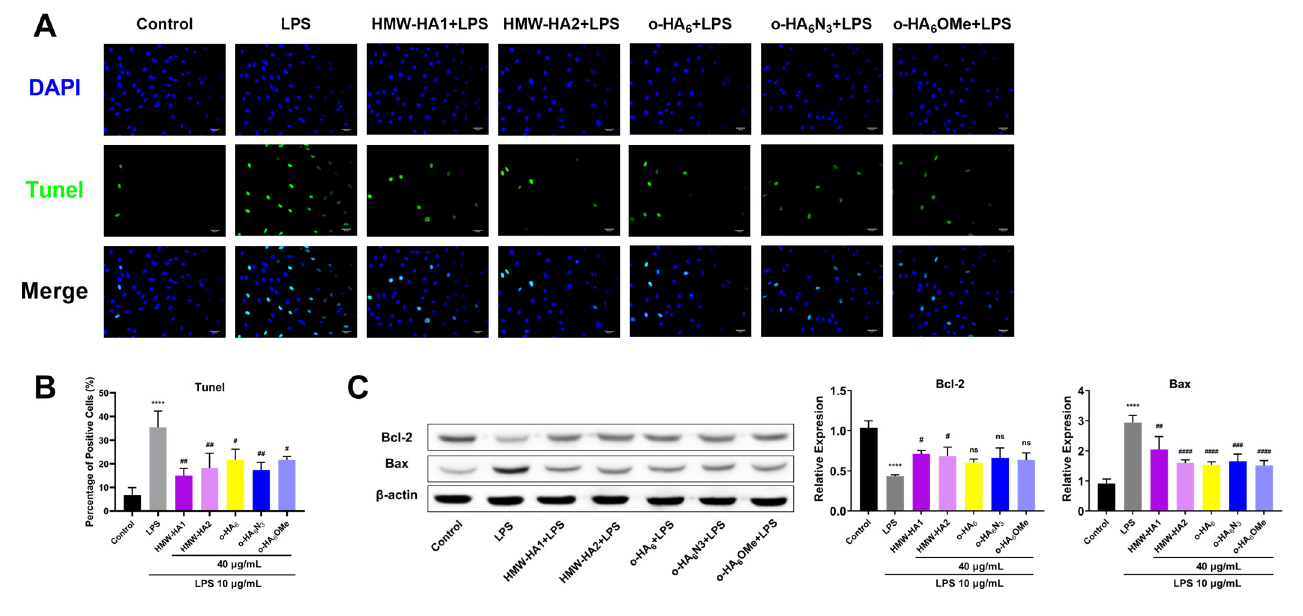
Figure 8. Anti-apoptotic effects of different HA derivatives on ATDC5 inflammatory injury. ATDC5 cells in the LPS group were stimulated with LPS (10 μ g/mL) for 24 h and then cultured in a medium containing 10% FBS for another 24 h. For different HA derivatives groups, ATDC5 cells were treated with LPS (10 μ g/mL) for 24 h and different HA derivatives (40 μ g/mL) for an additional 24 h, respectively. ( A ) Cell apoptotic pattern was examined by TUNEL assay. ( B ) Positive cell counts were plotted for each treatment group for three independent replicates. ( C ) Western blot analysis of the relative expression of Bcl-2 and Bax protein expression after treatment with different HA derivatives. **** p < 0.0001 vs. Control group; # p < 0.05, ## p < 0.01, ### p < 0.001, #### p < 0.0001, ns = not statistically significant vs. LPS group.